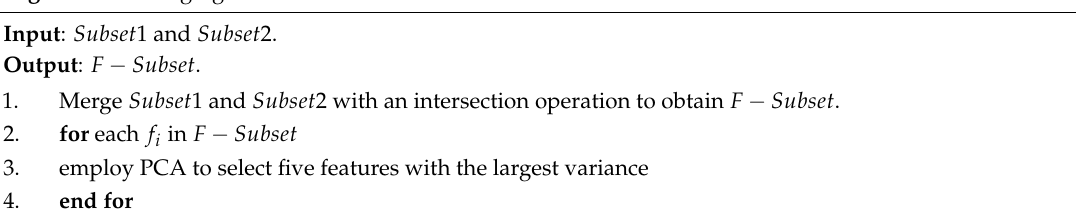
Algorithm 5 . Merging feature subsets.